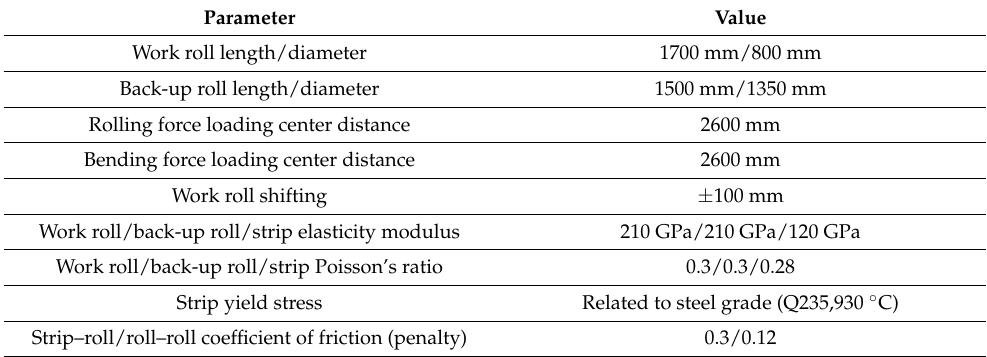
Table 1. Simulation model